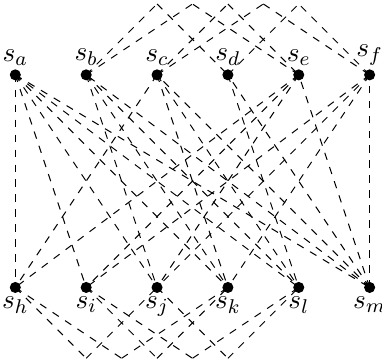
Figure 19 . Coxeter diagram, (cid:6)( P 2 ), for the the Coxeter group associated with order-4 dodecahe- dral honeycomb. Each pentagonal face of a dodecahedral cell has a dihedral angle of (cid:25) (cid:12)ve faces it intersects, and diverges from the other six faces of the